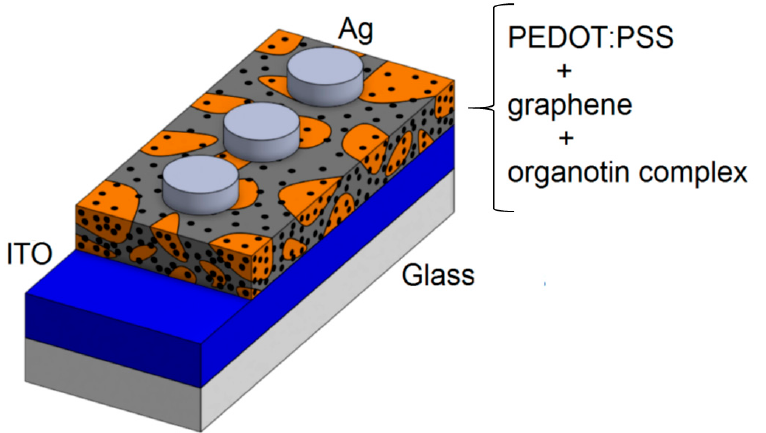
Figure 7. Device schematics.